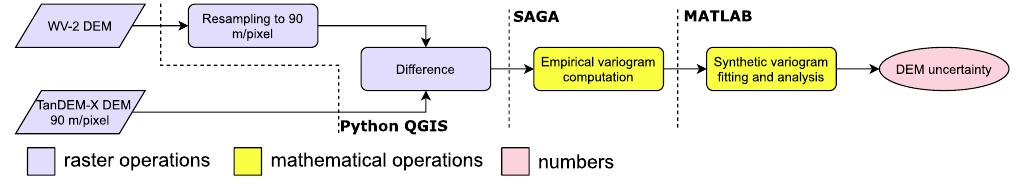
Figure 4. Procedure of the WV-2 DEM accuracy